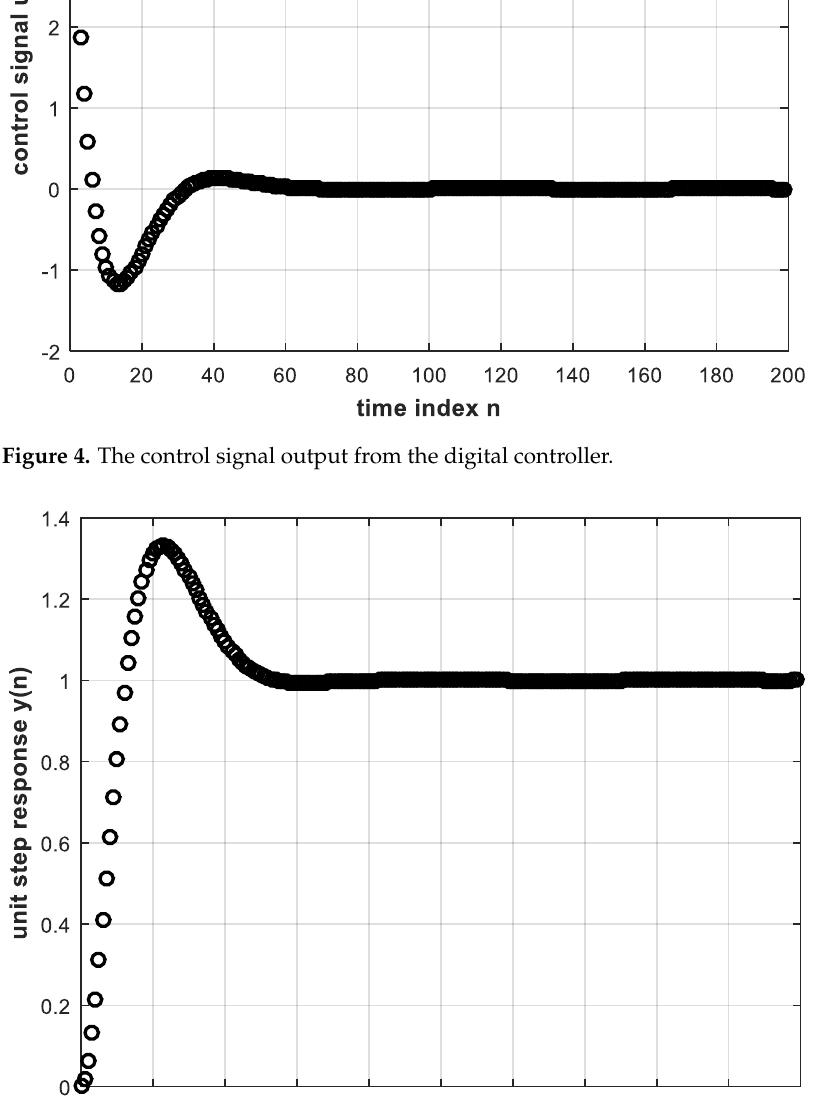
Figure 5. The unit step response of the feedback control system.